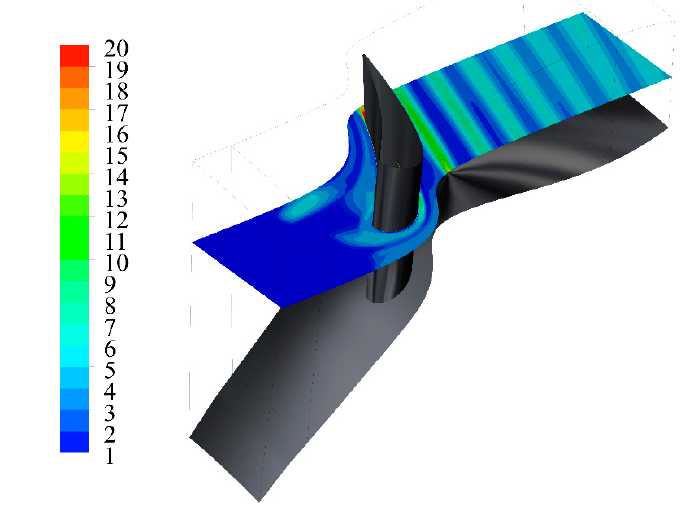
Figure 15. CO mass fractions for condition D calculated utilising the CFD model with FRC and the EDC. The CRN results for condition D have completely different behaviour. The concen- tration drops considerably from the inlet of the stator. The behaviour does not seem to be affected by the differences in temperature or pressure along the stator. The hypothesis for the different behaviour between CFD and CRN is that, locally, the CFD simulations are able to attain conditions in which CO 2 dissociation is possible, while these local conditions are not incorporated in the 1D-CRN. This hypothesis is reinforced by the analysis of the local CO concentration (Figure 16), in which most of the increase takes place along the blade walls and its wake, not modelled in the CRN. However, as for the case of NO, it is not expected that this behaviour occurs and that is most likely a shortcoming of the EDC model employed.